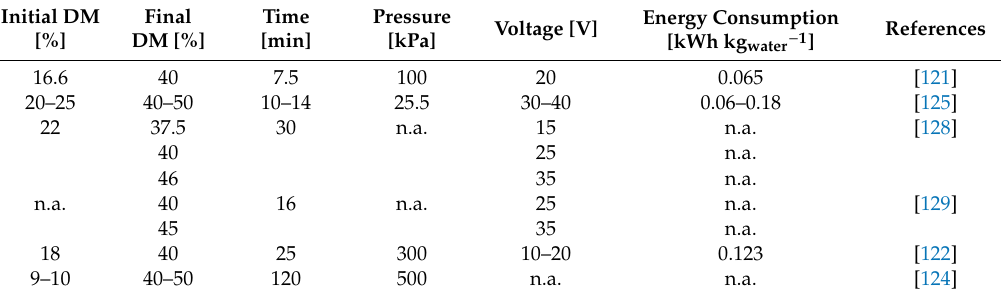
Table 4. Several applications of electro-osmosis